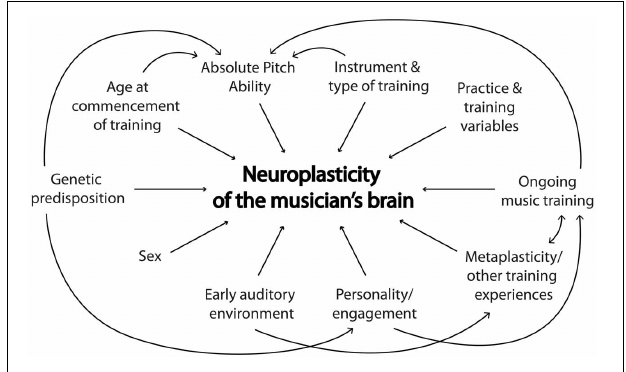
FIGURE 1 | A schematic representation of moderating variables of music-induced neuroplasticity and their